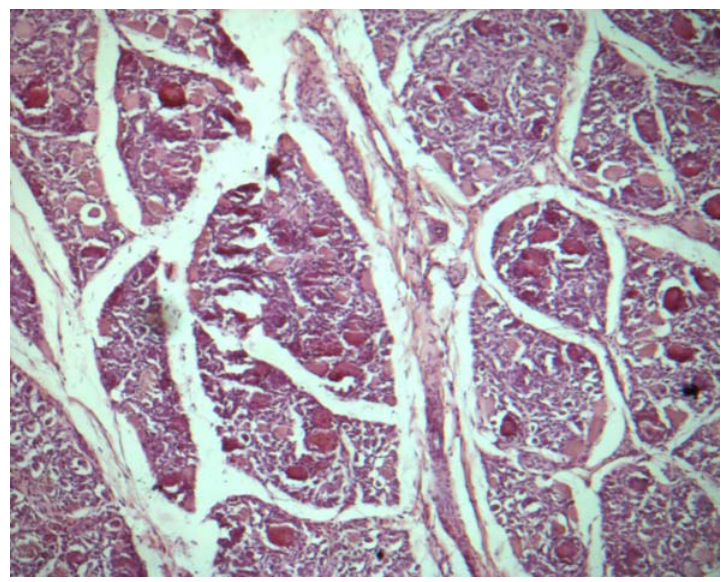
Figure 2. Necrotic muscular fibers. There are some areas of edema dividing the fibers (HE, 100X).